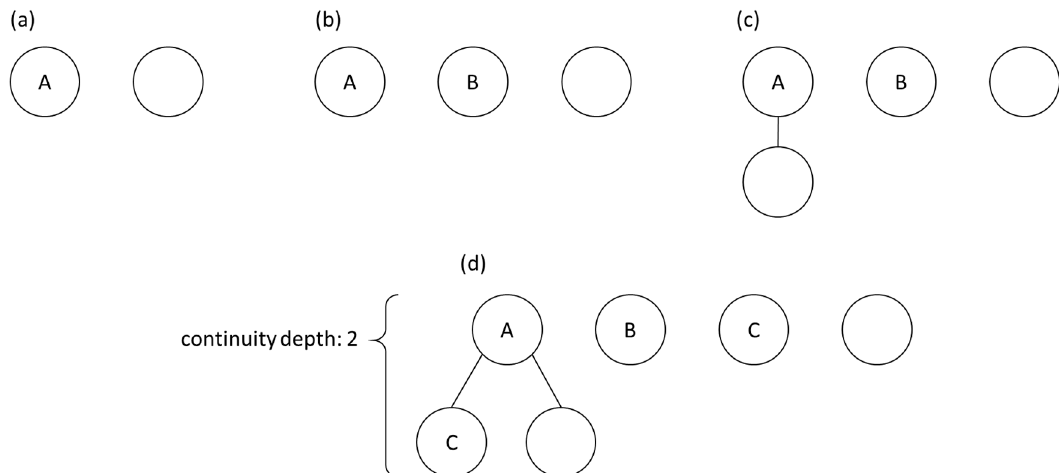
Figure 7. Continuity depth calculation: ( a ) Continuity graph after device A is connected; ( b ) Continuity graph after device B is connected; ( c ) Continuity graph after device A is disconnected; ( d ) Continuity graph after device C is connected.